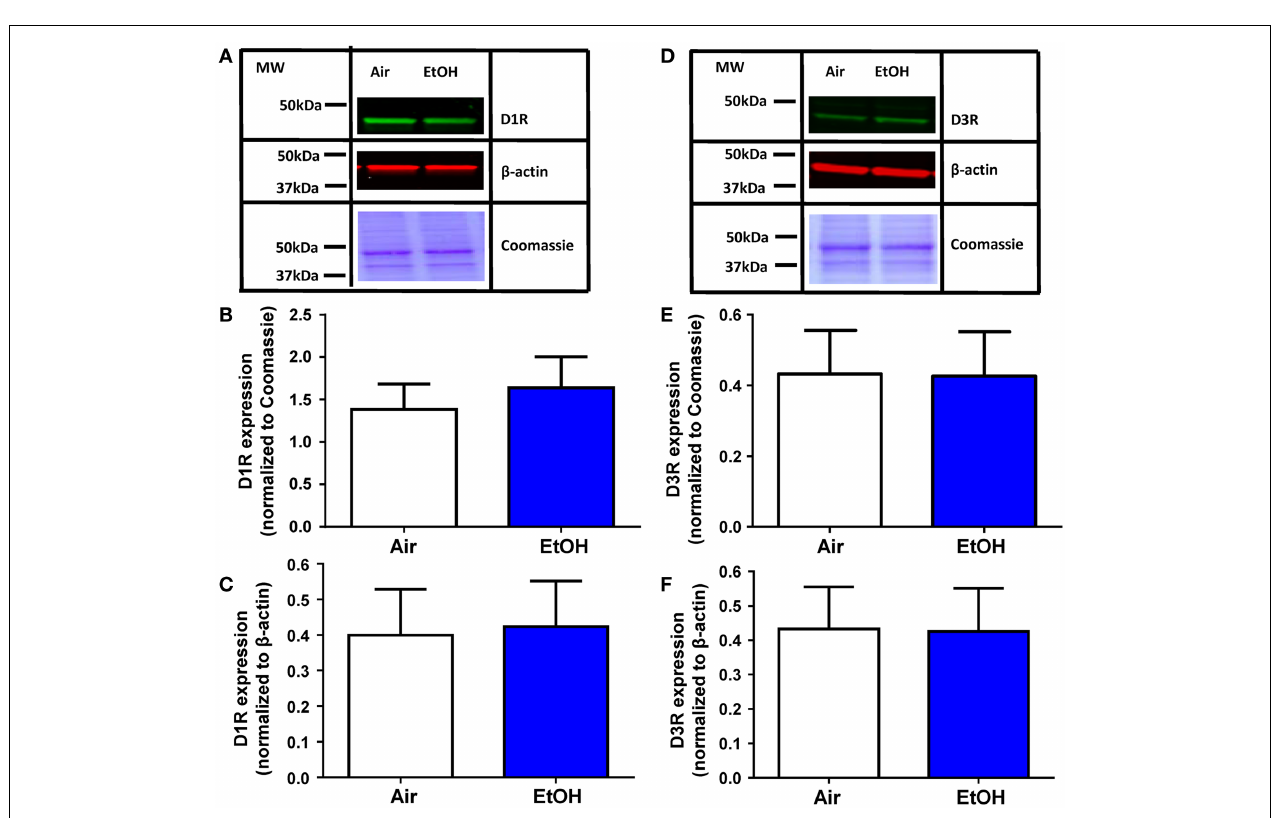
was not altered by EtOH exposure in either analysis. (D) Same as in (A) but for D3R. Graphic quantification of D3R expression normalized to (E) Coomassie-stained bands and (F) β -actin. D3R expression was not altered by EtOH exposure in either analysis. N = 8 animals from 4 Air and 4 EtOH litters for all western